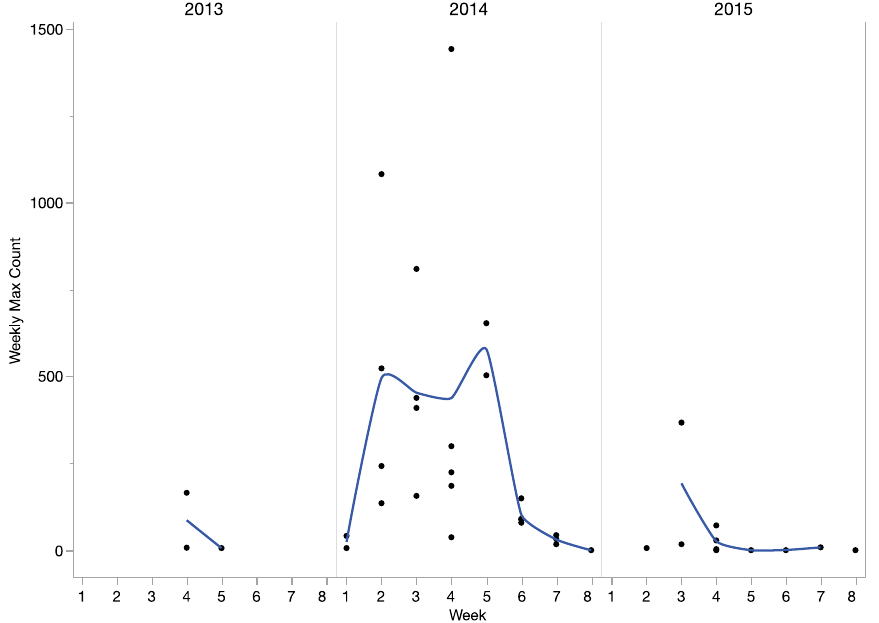
Figure 2. Maximum daily counts aggregated by week, 2013–2015, on the campus of Oregon State University, Corvallis, Oregon USA. Counts of zero are not illustrated (see Figure 1). Lines are Savitzky–Golay-fitted means [14] implemented with JMP [15].